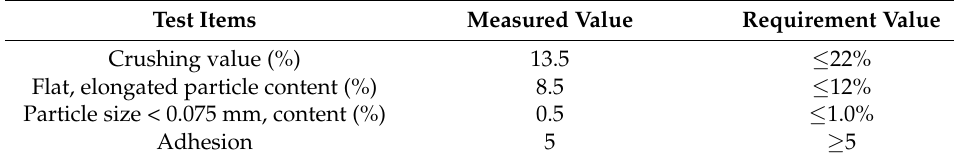
Table 2. Basic technical indicators of coarse aggregates.